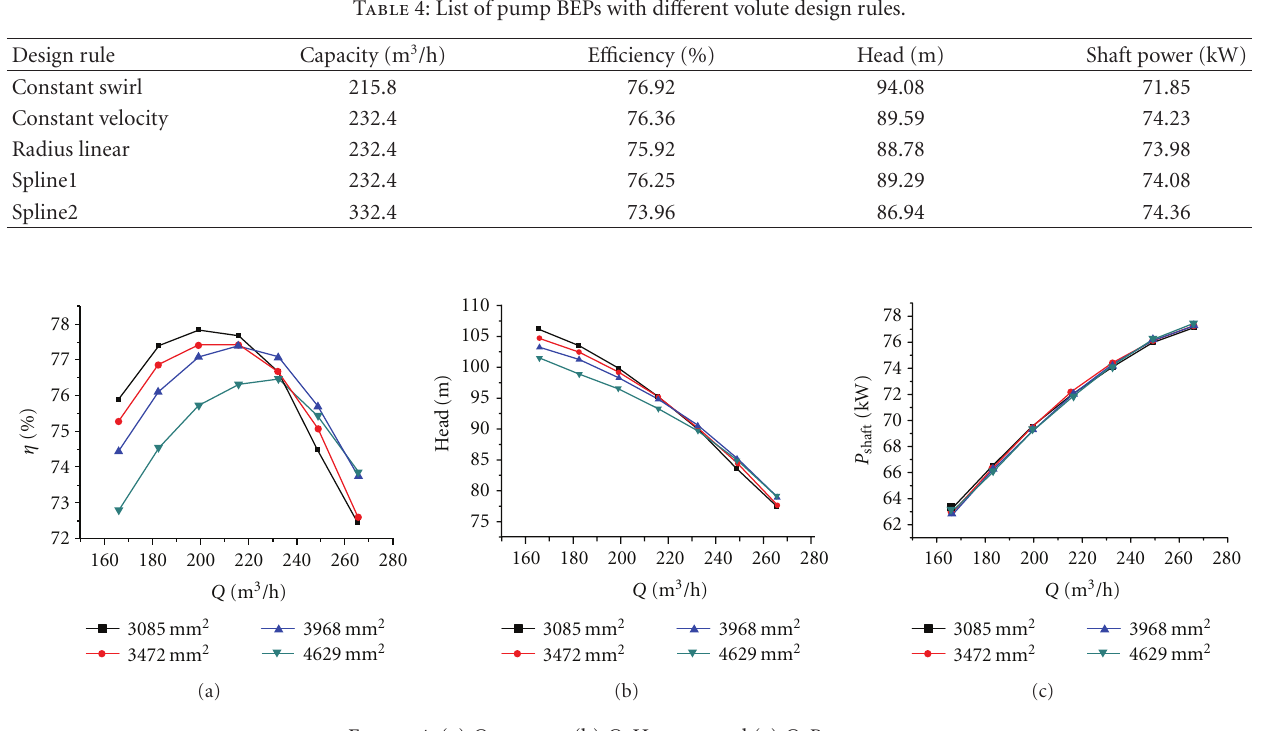
Figure 4: (a) Q - η curve, (b) Q - H curve, and (c) Q - P shaft